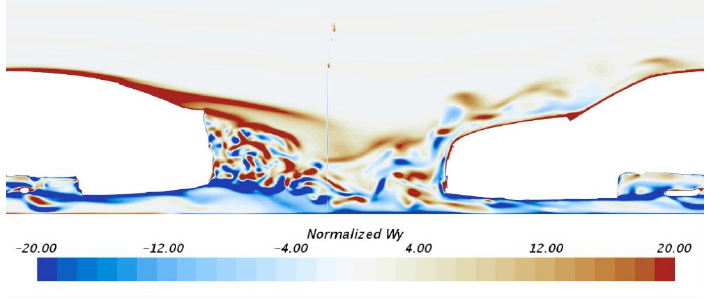
Figure 17. ω Y ∗ Along the Plane of Symmetry Showing Vortex Impingement by the Trailing Vehicle.